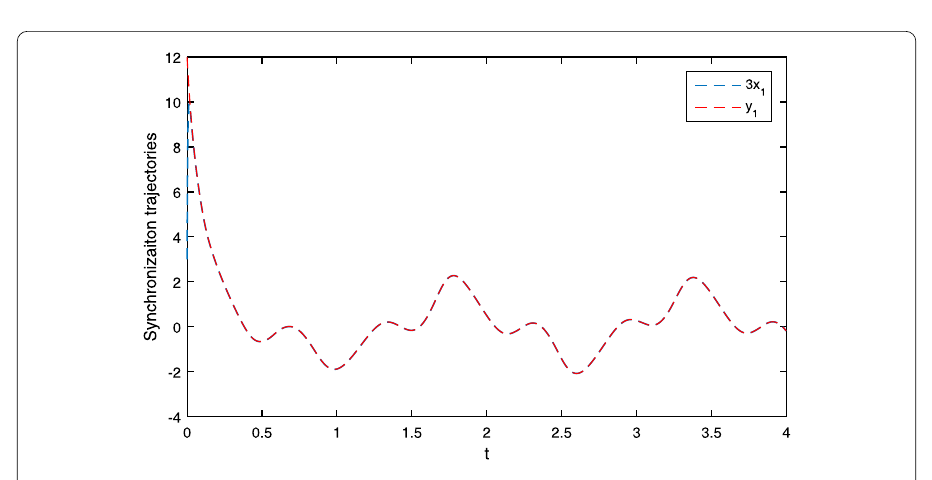
Figure 9 The synchronization trajectories of x 1 , y 1 with β = 3